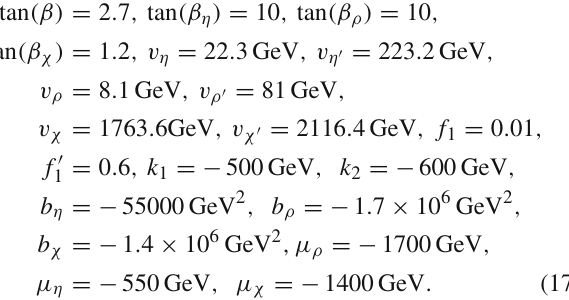
Fig. 2 M h vs X t for various values of v 331 . We took m SUSY = [ 500 , 1000 ] m SUSY R